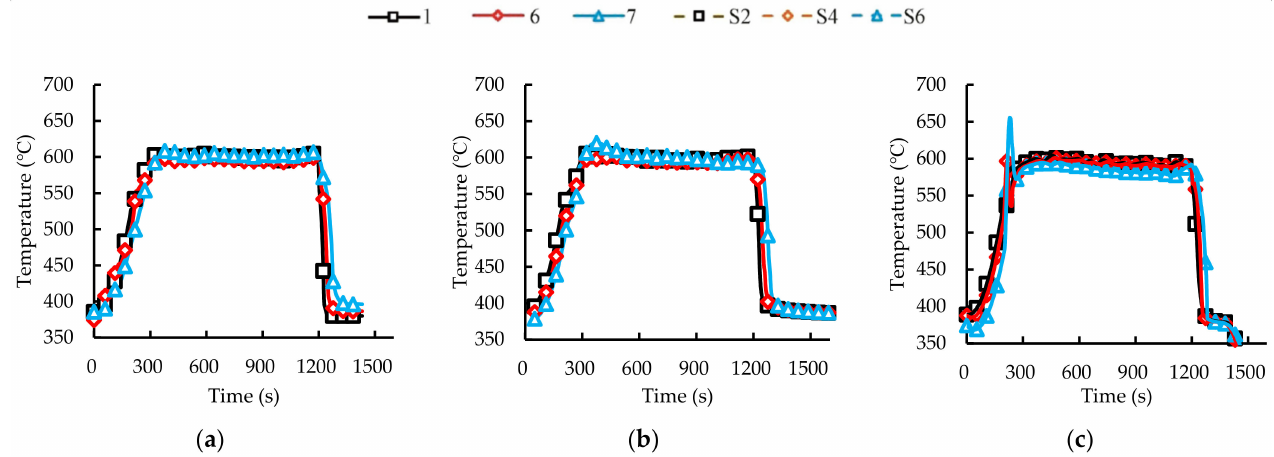
Figure 14. Comparison between the simulation result and test result. ( a ). 15.5 g ( b ). 21.9 g ( c ). 36.5 g. Table 9. Comparison of the test results and simulation results with different initial soot loading quantities. Parameter Soot Quantity: 15.5